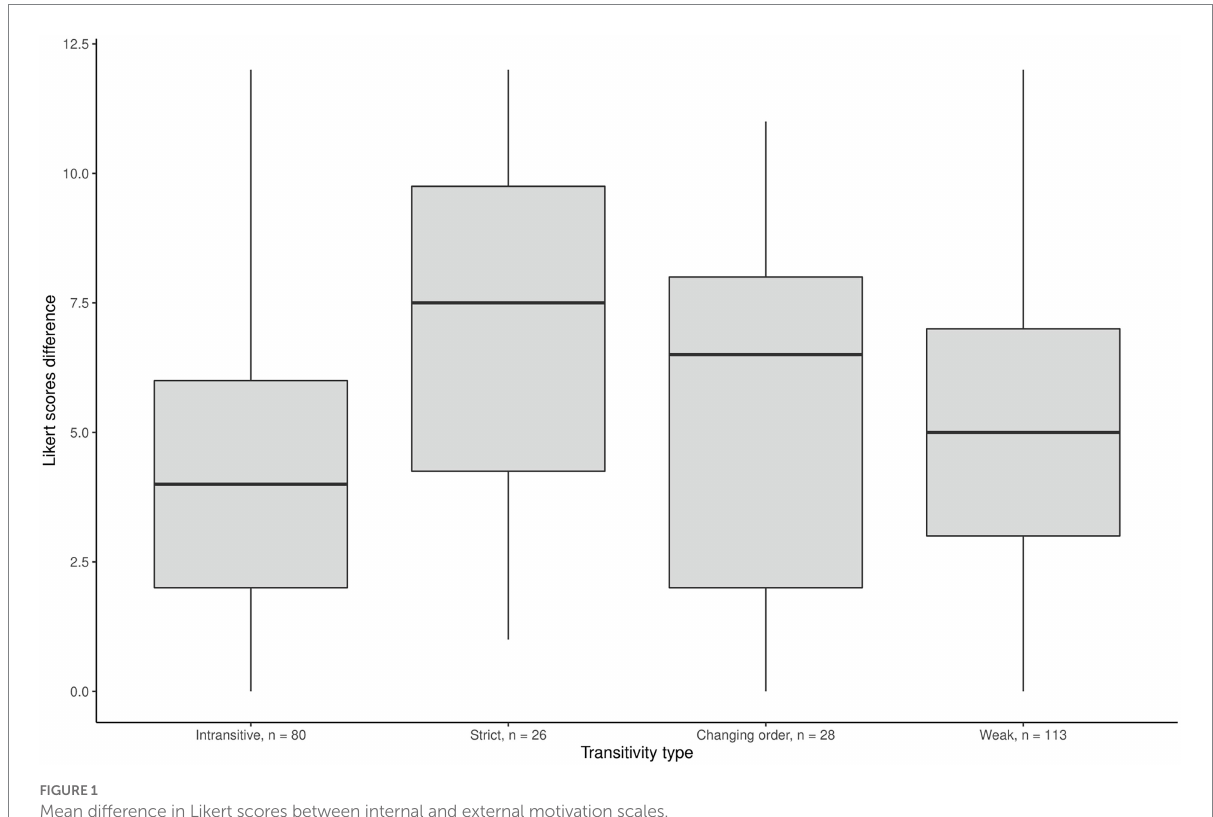
FIGURE 1 Mean difference in Likert scores between internal and external motivation scales.